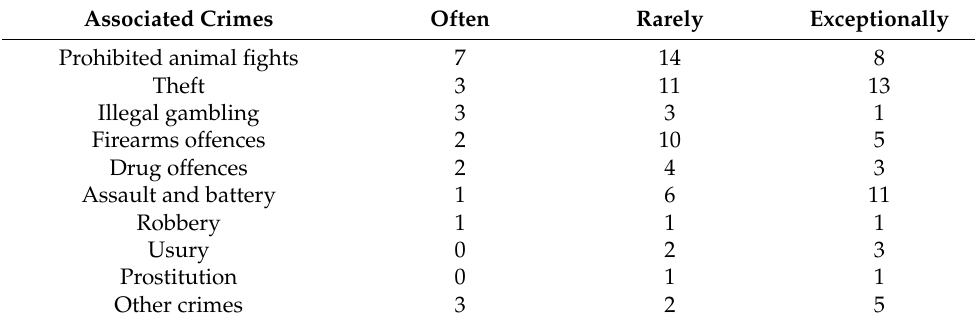
Table 1. Crimes associated with the felony of animal cruelty ( n = 99).